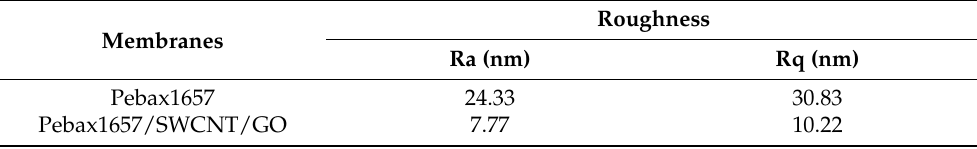
Figure 8. AFM images of the surface ( a ) pristine Pebax membrane; ( b ) Pebax/GO/SWCNTs mem- brane (range of scanning 3 × 3 µ m). Table 1. Surface roughness parameters of Pebax1657 membranes and MMMs.